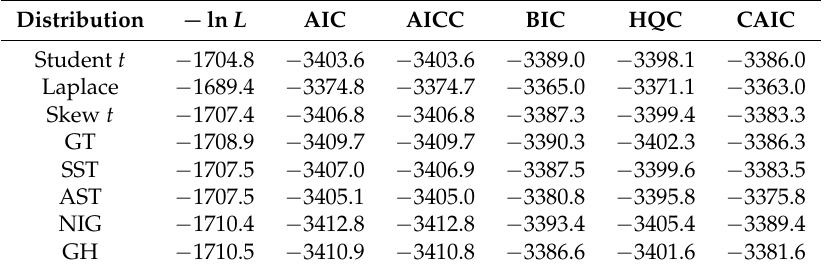
Table 5. Fitted distributions and results for daily log returns of the exchange rates of Dash from